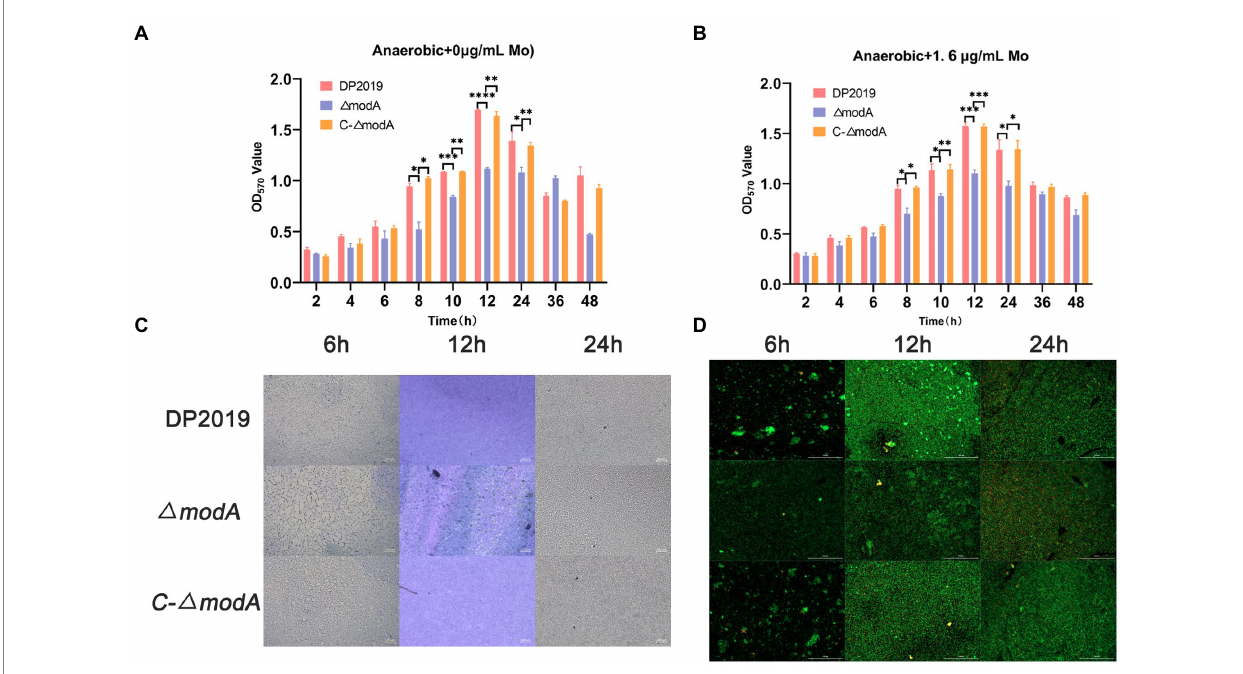
FIGURE 4 Detection of biofilm-forming ability. (A) Quantification of biofilm formation. Biofilm formation was quantified by measuring the absorbance at various time points after Crystal Violet staining under anaerobic growth conditions. The optical density (570 nm) of the solution extracted with ethanol/acetone correlated with the level of biofilm formation. (B) Quantification of biofilm formation. Biofilm formation was quantified by measuring the absorbance at various time points after Crystal Violet staining in 1.6 μ g/mL molybdate under anaerobic growth conditions. (C) Images of biofilms stained with Crystal Violet at different time points. (D) The two-color fluorescence assay at various time points under anaerobic growth conditions. Data are presented as the mean ± S.D. of three independent experiments, * p < 0.5, ** p < 0.1, *** p < 0.001, **** p <